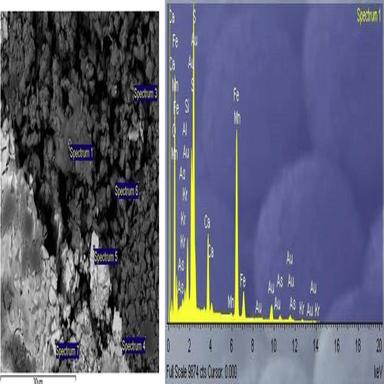
a)SEM image of the sample Gornje Polje Dudin Krs, b)EDS curve.